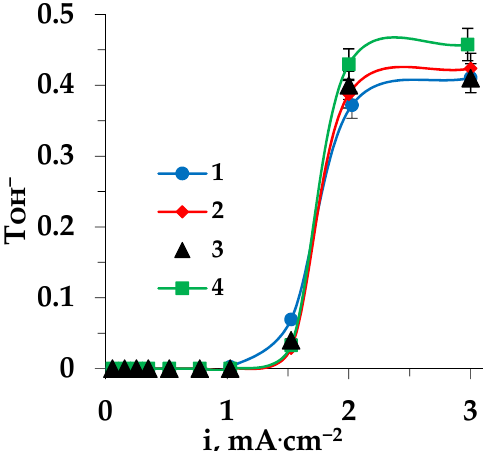
Figure 5. Dependence of the hydroxyl ion effective transport number on the current density for the MA-41 membrane during the electrodialysis of Trp + NaCl solutions: 1—pristine membrane in ED of NaCl solution, 2—pristine membrane, 3—regenerated membrane, 4—fouled membrane.